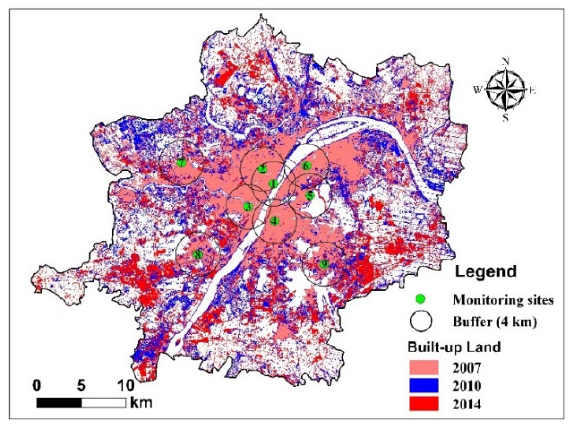
Figure 4. Built-up land in Wuhan city in 2007, 2010, 2014.